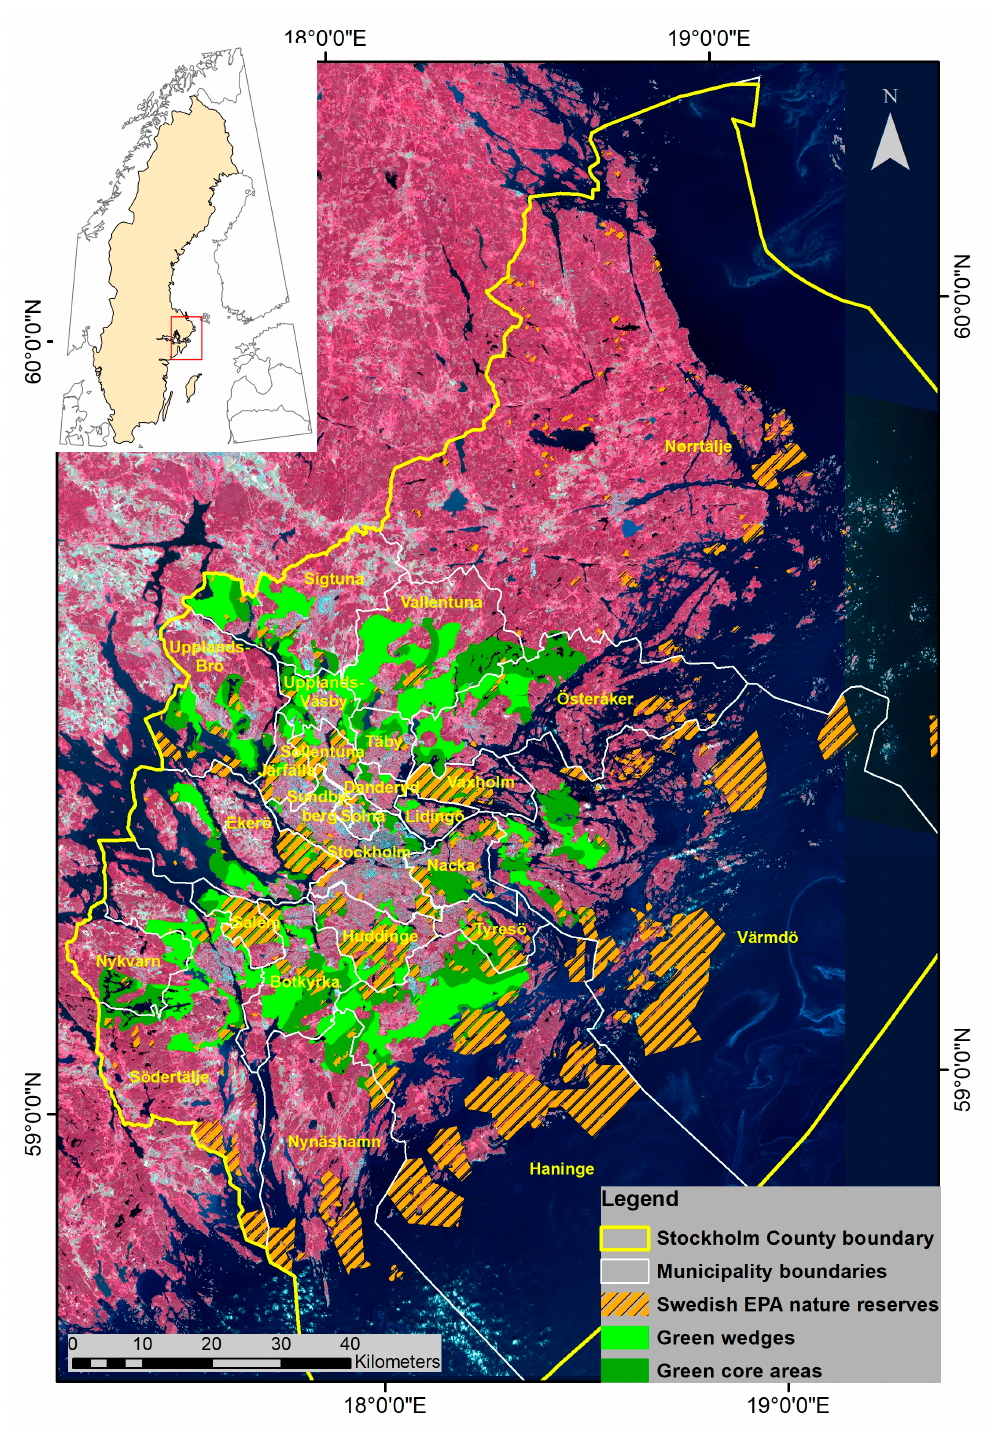
Figure 1. Study area: Stockholm County and municipality boundaries are outlined in yellow and white respectively. Municipalities are labeled in yellow. Green wedges and nature reserves located within the county are also shown with Sentinel-2A multispectral instrument (MSI) imagery from August 23, 2015 as backdrop.